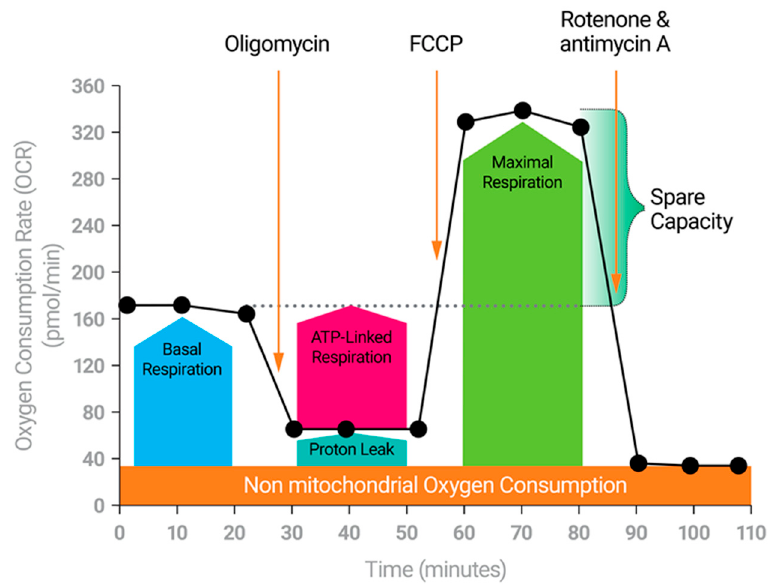
Figure 2. The Cell Mito Stress Test. The Cell Mito Stress Test measures the key parameters of mitochondrial function including basal respiration, ATP-linked respiration, maximal respiration, Spare Respiratory Capacity, and non-mitochondrial respiration.